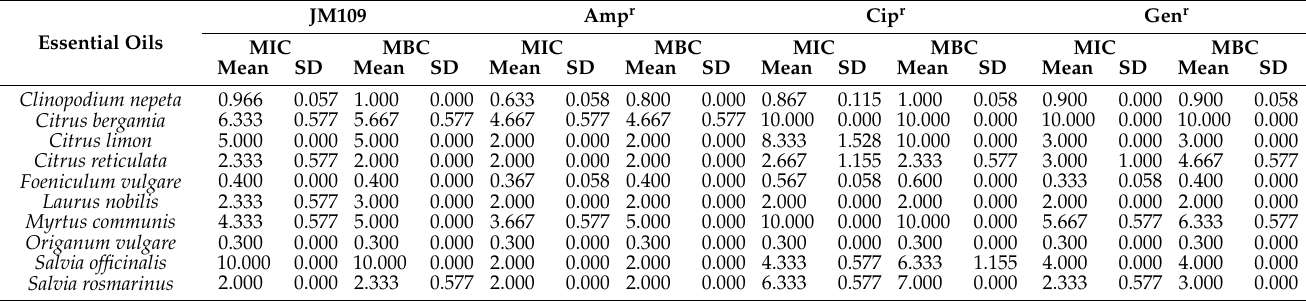
Table 1. Minimal inhibitory concentrations (MIC) and minimum bactericidal concentrations (MBC) expressed as µ L/mL of essential oils against JM109 Escherichia coli parental cells, and its derivate ampicillin-, ciprofloxacin-, and gentamicin-resistant cells. The values represent the mean of three independent triplicate experiments with standard error and mean. The OD 600 values of the oil-free positive and negative controls were 1.85 ± 0.12 and 0.035 ± 0.01, respectively. JM109